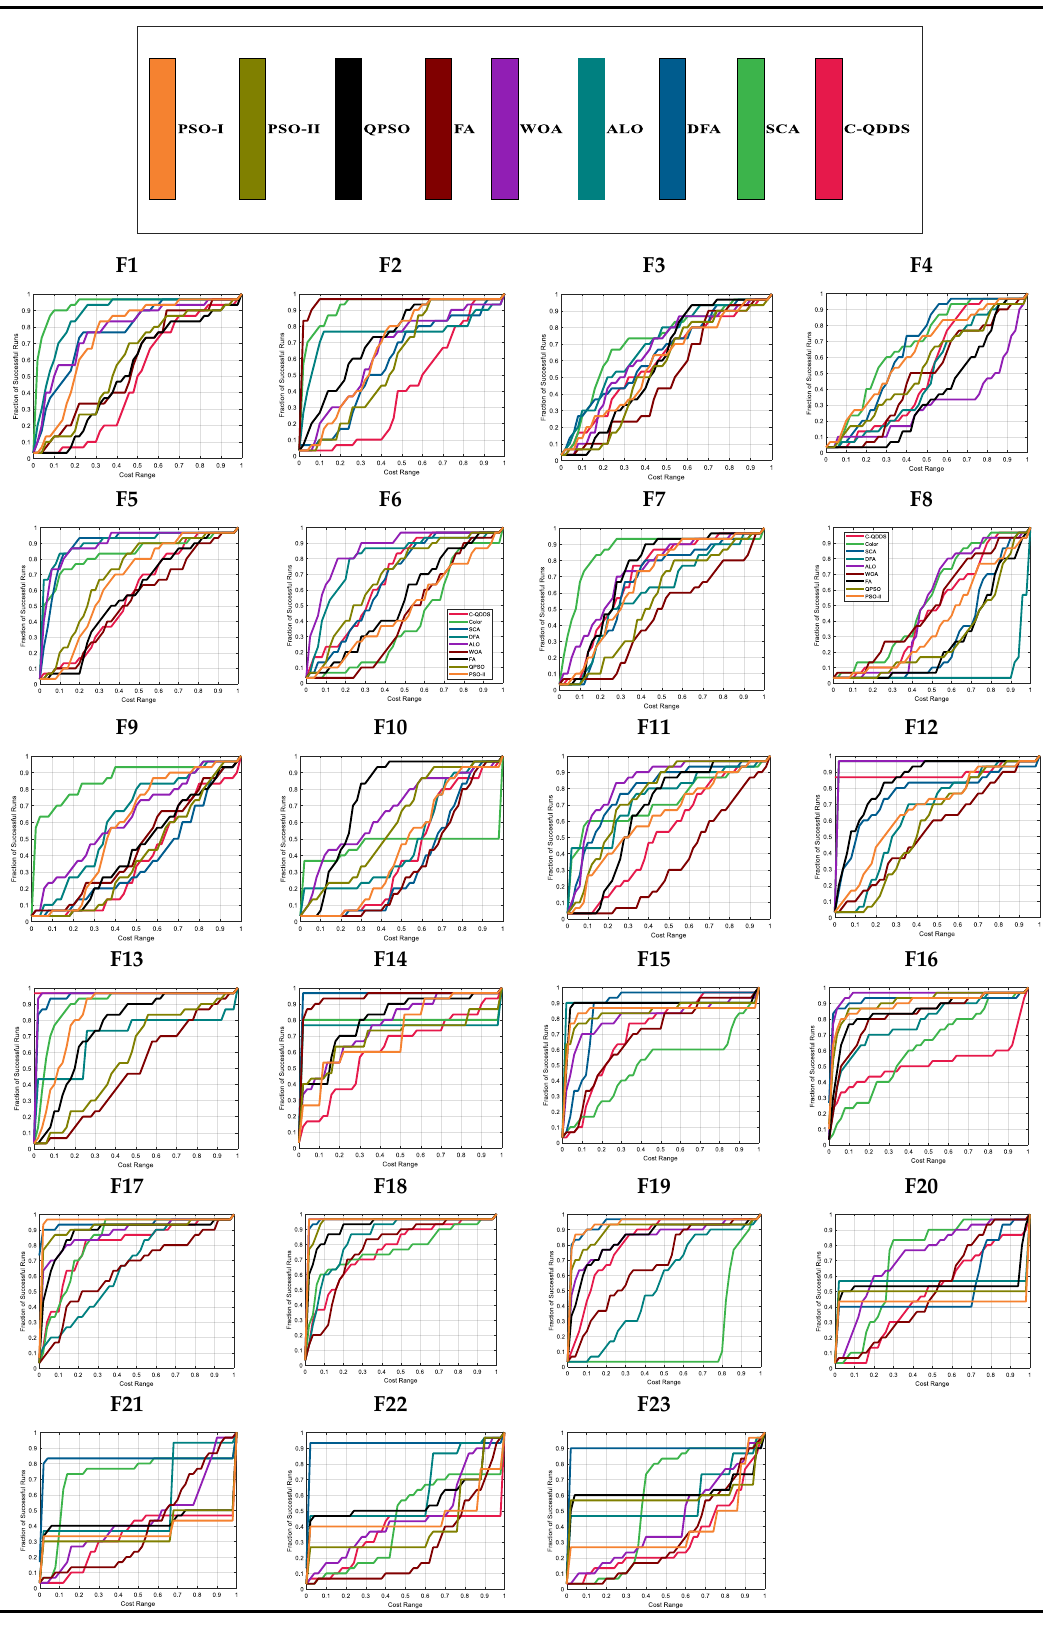
Table 18. Precision plots (fraction of successful runs vs. cost range) for the 23 benchmark functions.